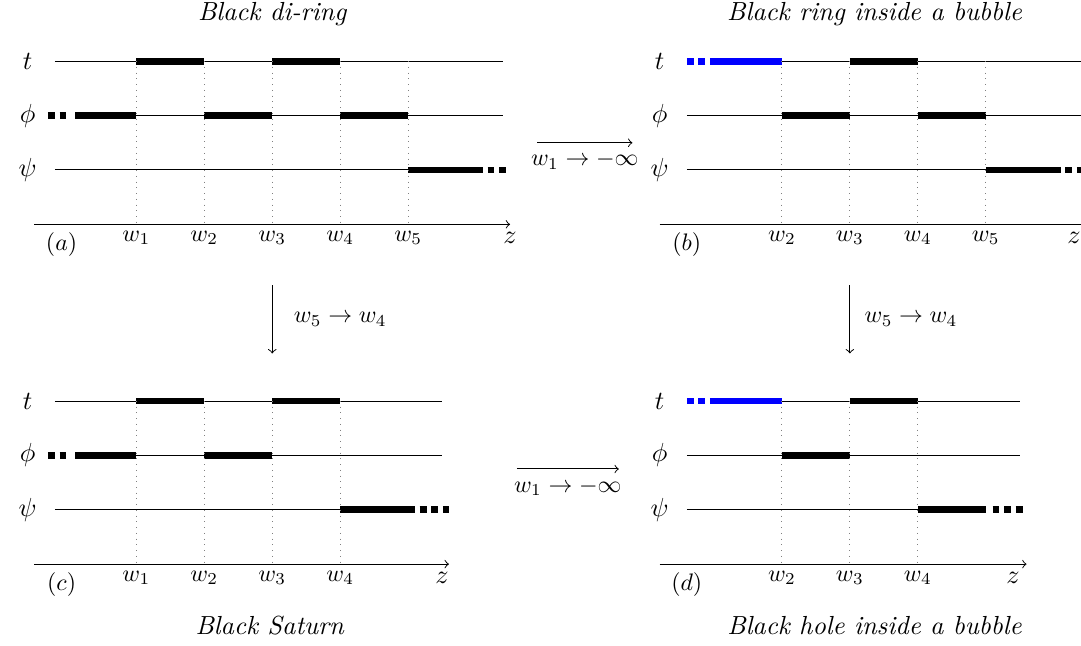
Figure 11 . ( a ) Rod diagram for a coaxial double black ring system. The limit w ( b ) the single black ring in the expanding bubble. The limit of ( a ) for w 5 Saturn. Its limit for w 1 gives ( d ) the five-dimensional black hole in an expanding bubble. → −∞ The rod limits commute, so the latter diagram can also be obtained from ( b ) for w 5